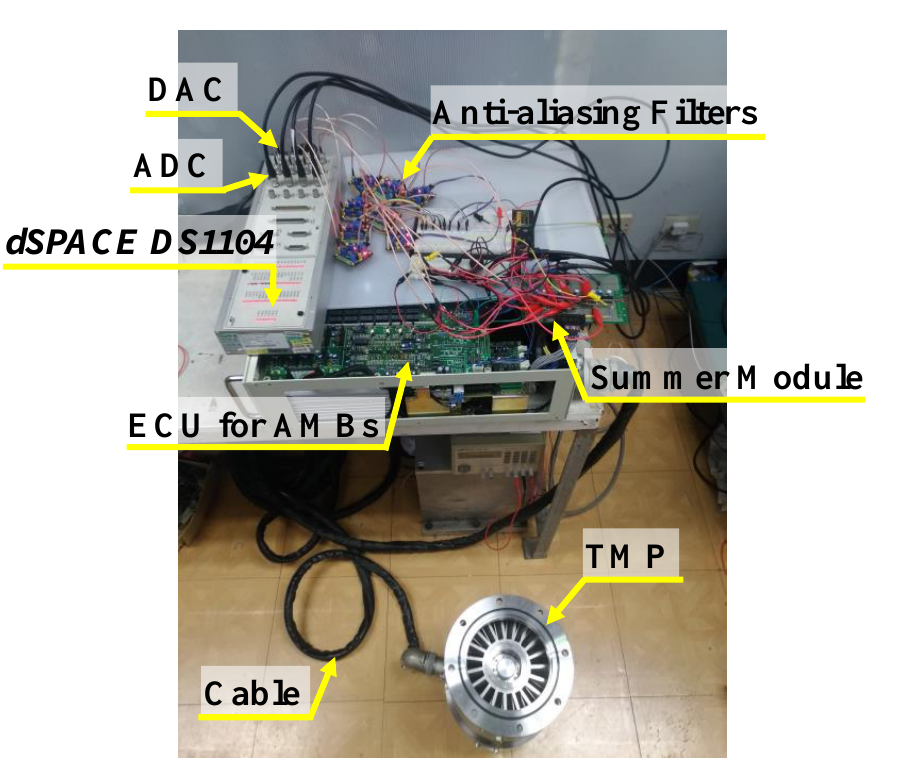
Figure 15. Test rig for system identification on rotor/AMB dynamics.